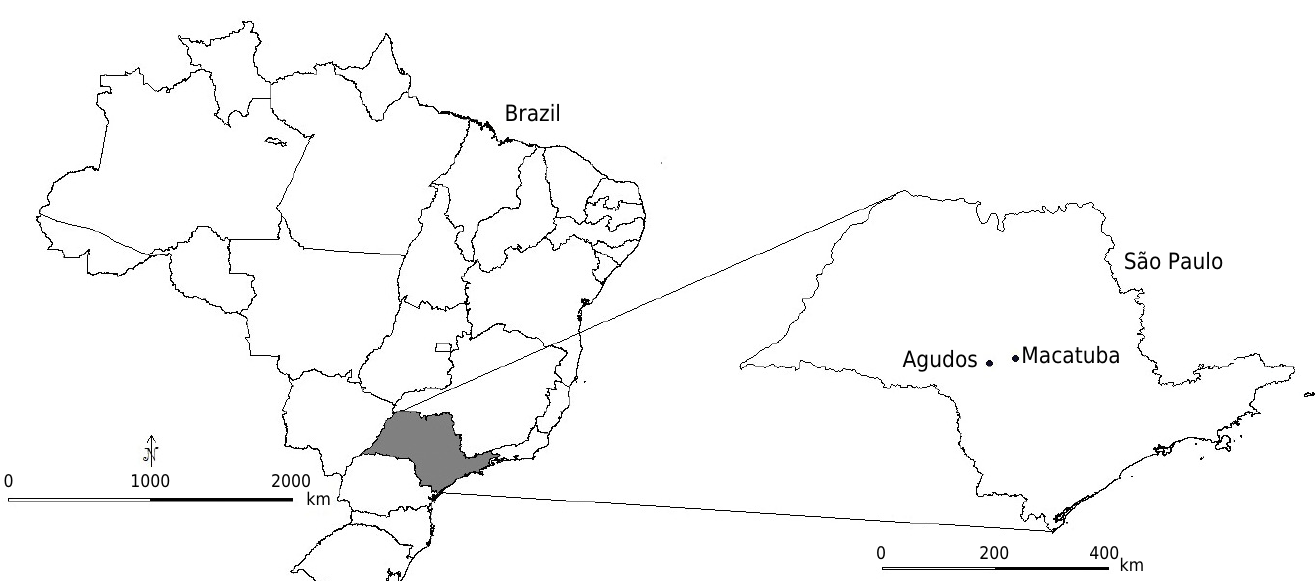
Figure 1. Geographical location where the two sugarcane experiments were set up, in Agudos and Macatuba, São Paulo